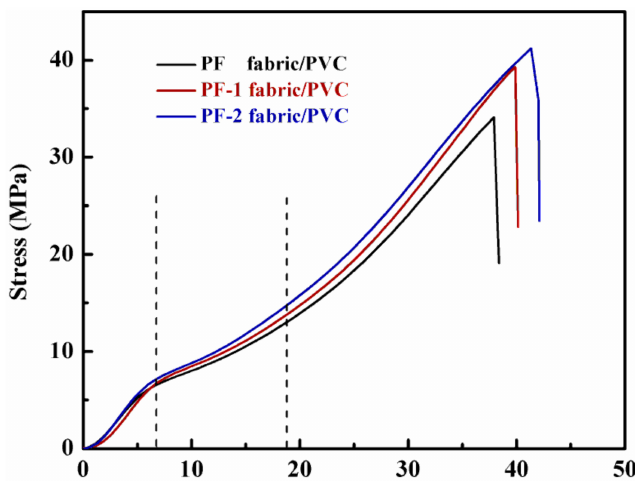
Figure 13. Typical stress–strain curves of the composites.